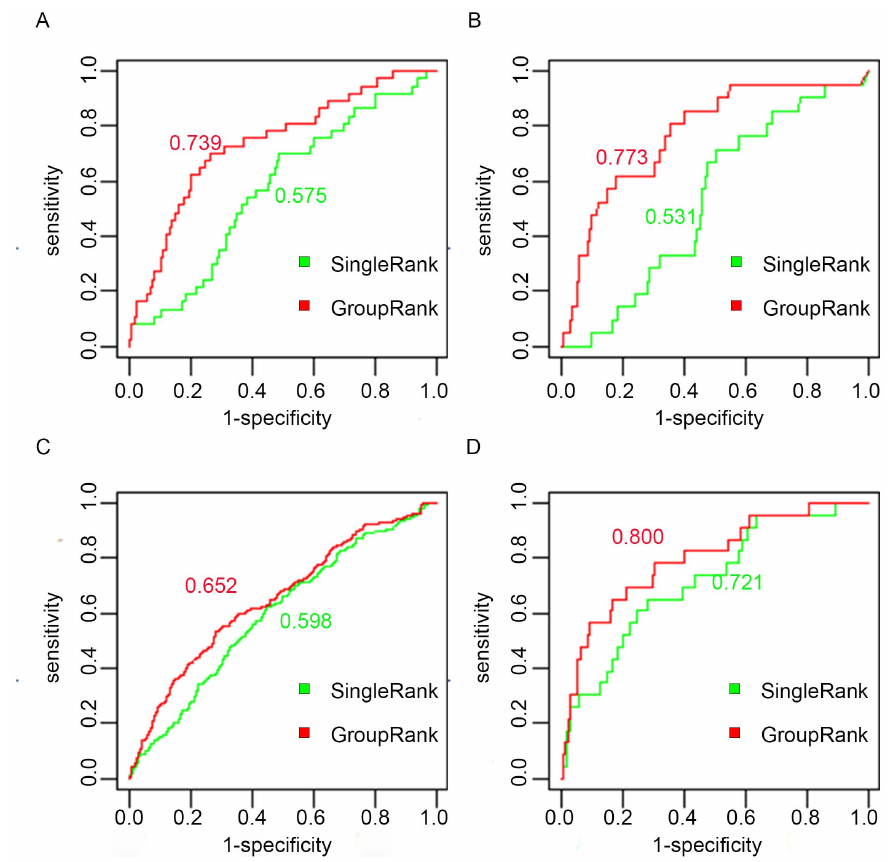
Figure 3. ROC curves of GroupRank and SingleRank. Performance validation using ROC curves. The AUC values of GroupRank and SingleRank achieved in each cancer type are labeled. From A to D, the cancer types are lung cancer, kidney cancer, leukemia and breast cancer.